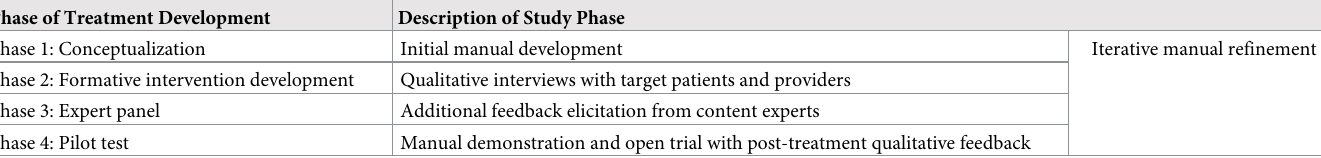
Table 1. Treatment development